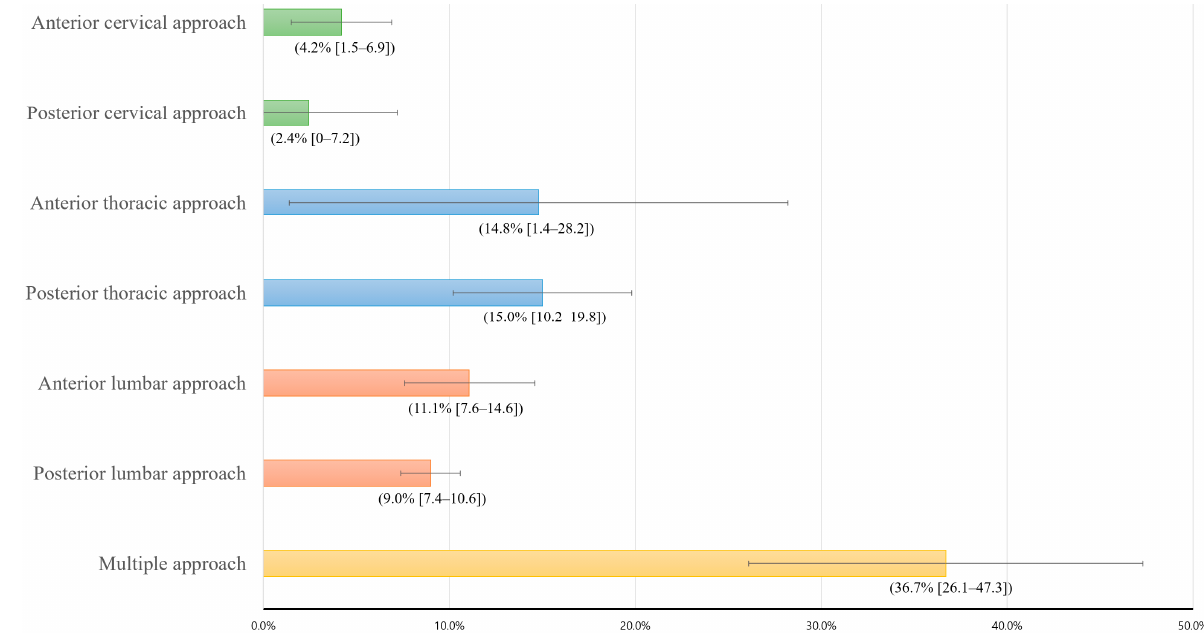
Figure 4. Recurrence rates according to the surgical procedures. The numbers in parentheses mean recurrence rates and their 95% confidence intervals.